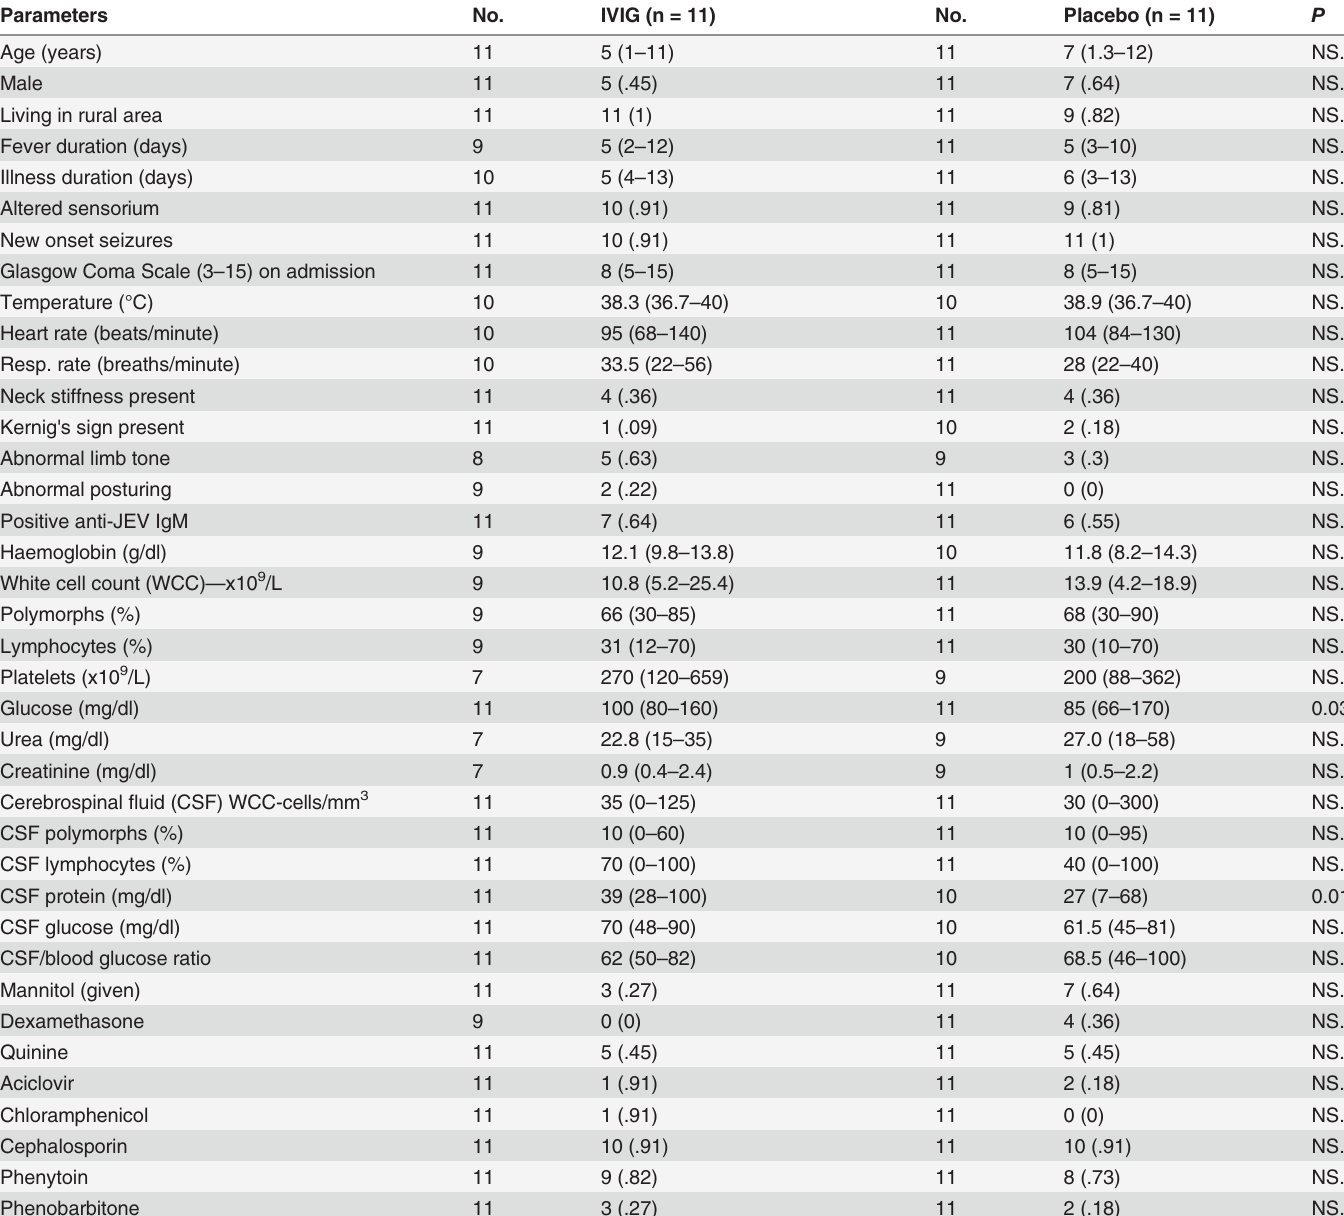
Table 1. Baseline characteristics of trial